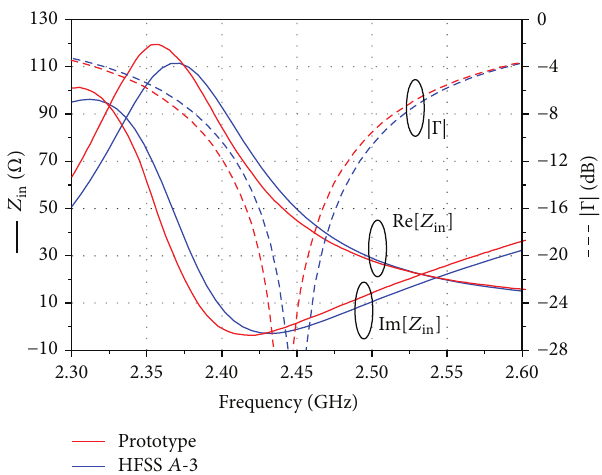
Figure 24: Input impedance and reflection coefficient magnitude.